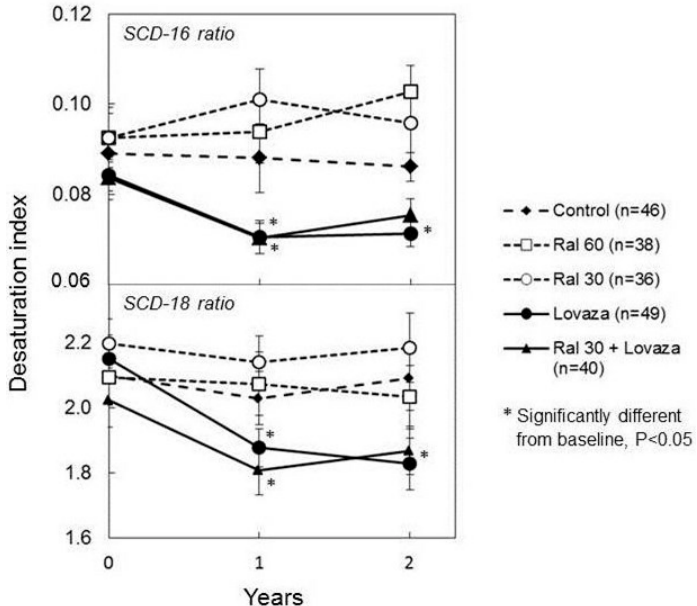
Figure 2. Individual and combined effects of Lovaza and Raloxifene on desaturation index, an indicator of stearoyl-coA-desaturase (SCD-1) activity. Data represent means ± SEM. Reproduced with permission from [63].